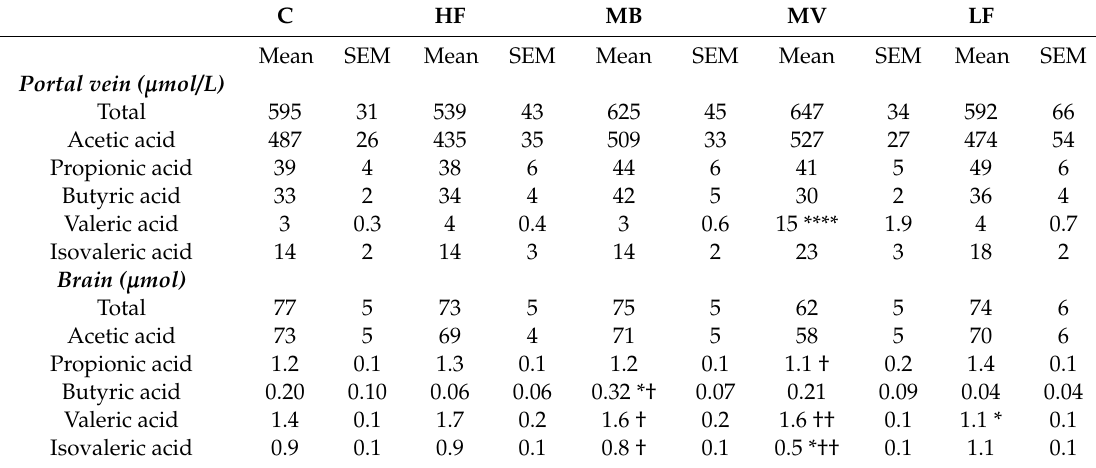
Table 2. Short-chain fatty acids in the portal vein and brain in conventional rats fed a pure high-fat diet (C), or Apolipoprotein E-knockout (ApoE- / -) rats fed a low-fat diet (LF) or high-fat diet (HF), pure or supplemented with 1% monobutyrin (MB) or monovalerin (MV) for 5 weeks ( n = 10 / group). Values are means ±